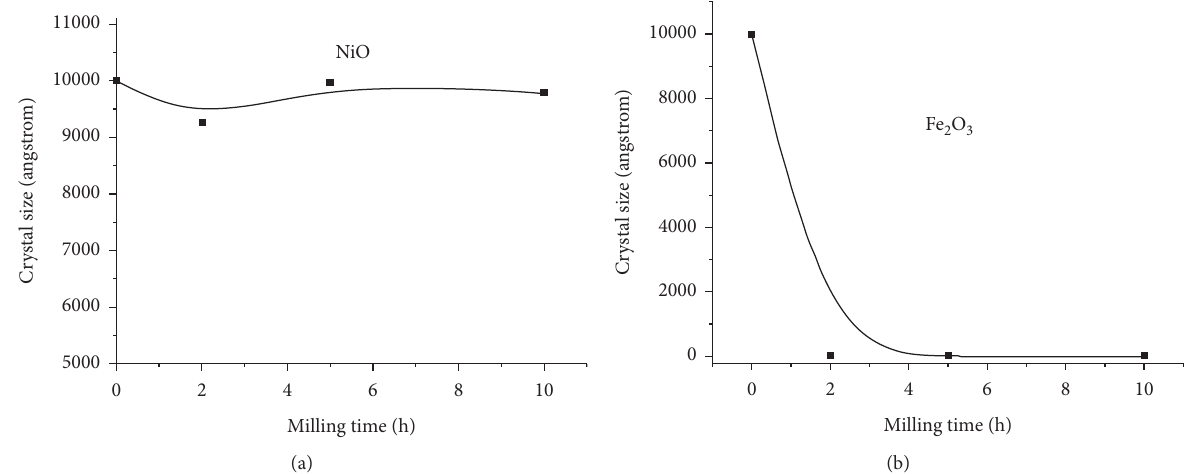
Figure 4: The effect of ball-milling on the grain size; (a) NiO. (b) Fe